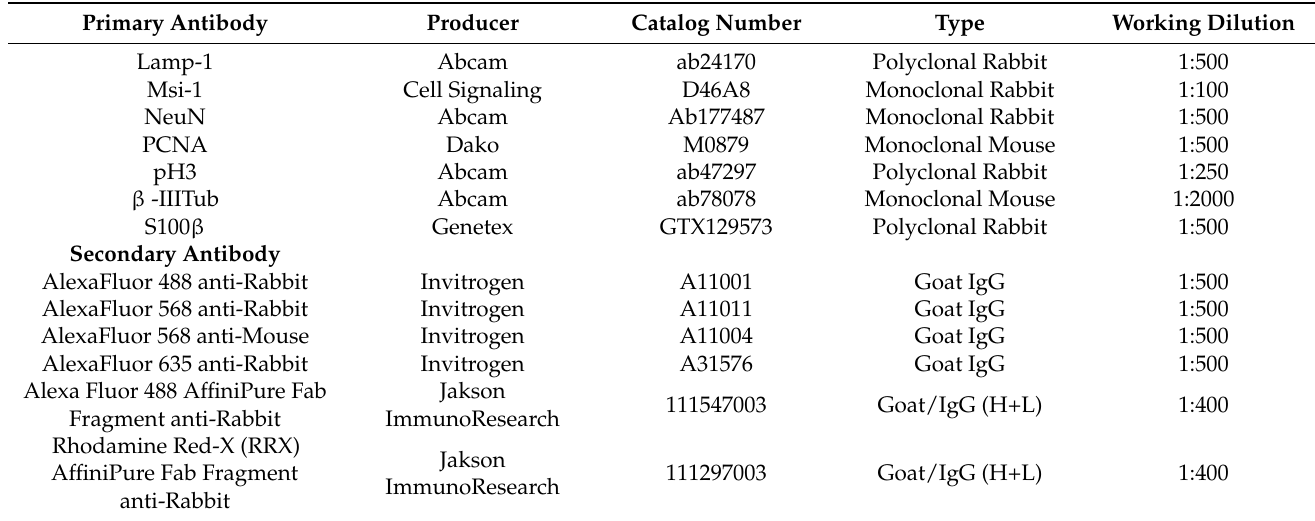
Table 1. List of all primary and secondary antibodies utilized in this